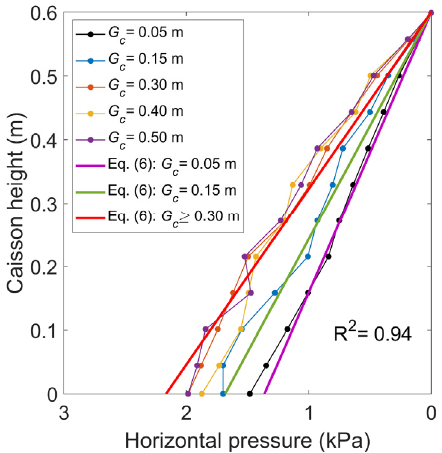
Figure 12. Comparison of the earth pressures measured with the suggested formula for the five different shoulder widths that were tested in this study.